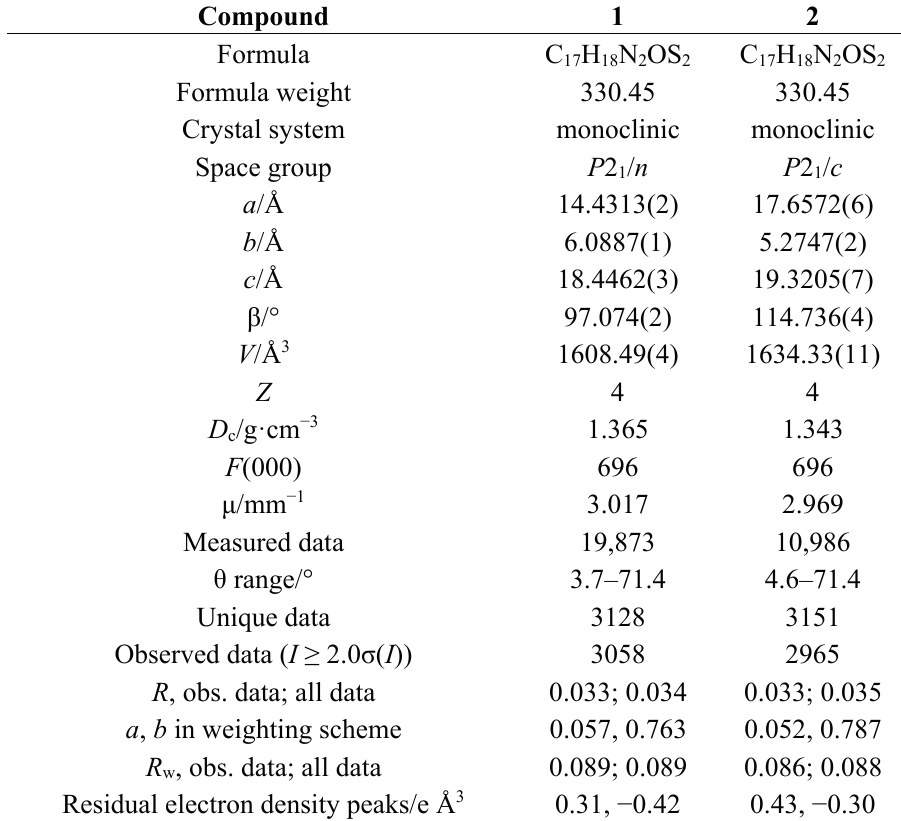
Table 6. Crystallographic data and refinement details for 1 and 2